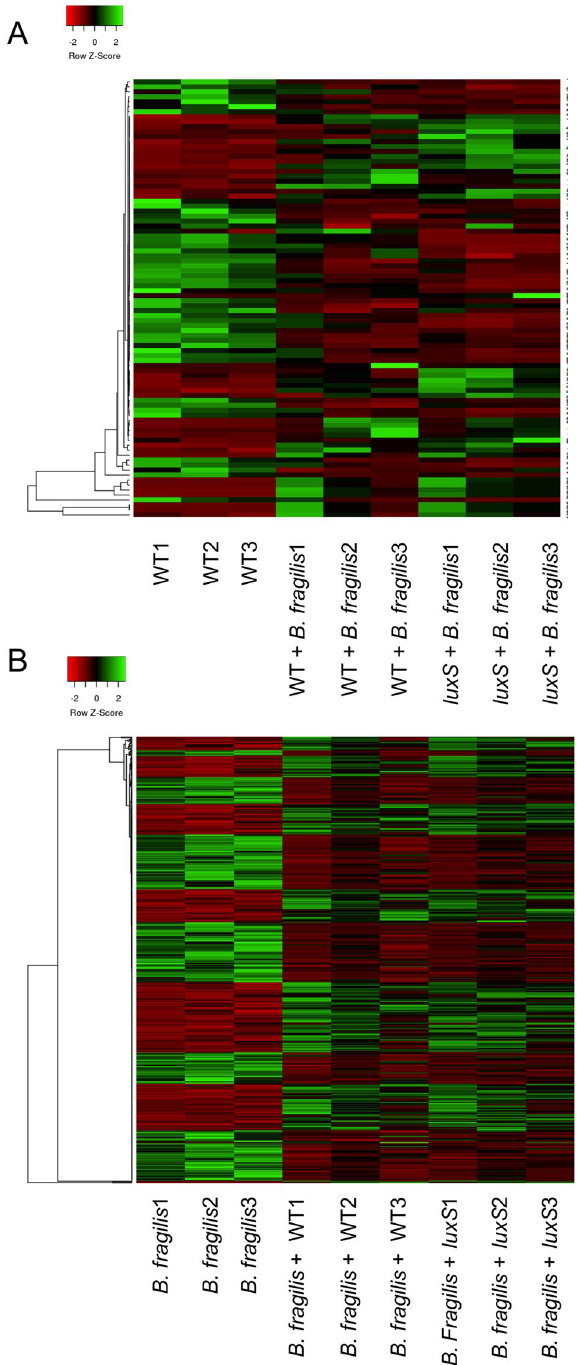
Figure 6. Dual species RNA-seq shows modulation of metabolic pathways in C . difficile WT, luxS and B . fragilis . Heat maps showing clustering of up- and down-regulated genes in ( A ) C . difficile WT and luxS co-cultured with B . fragilis compared to C . difficile WT mono-culture, and in ( B ) B . fragilis co-cultured with C . difficile WT and luxS compared to B . fragilis mono-culture. Red indicates genes that are down-regulated, whilst green indicates genes that are